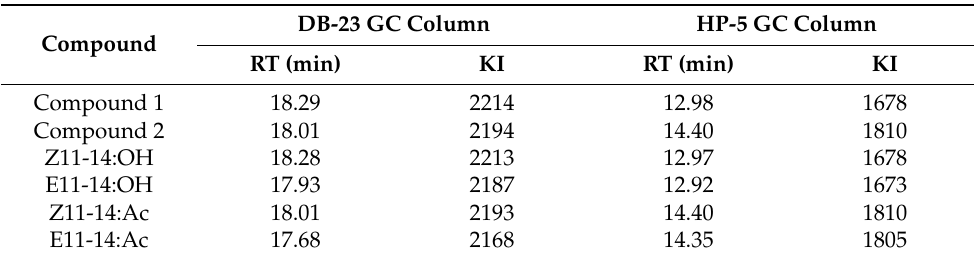
Table 2. Gas chromatography–mass spectrometry (GC–MS) analysis of natural pheromone extract of Archips strojny and synthetic ( E ) and (Z) configuration standards on different GC columns (RT: retention time; KI: Kovats index).